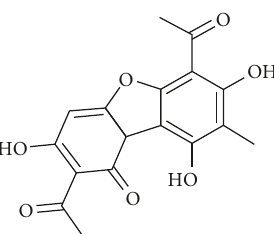
Figure 1: Molecular representation of